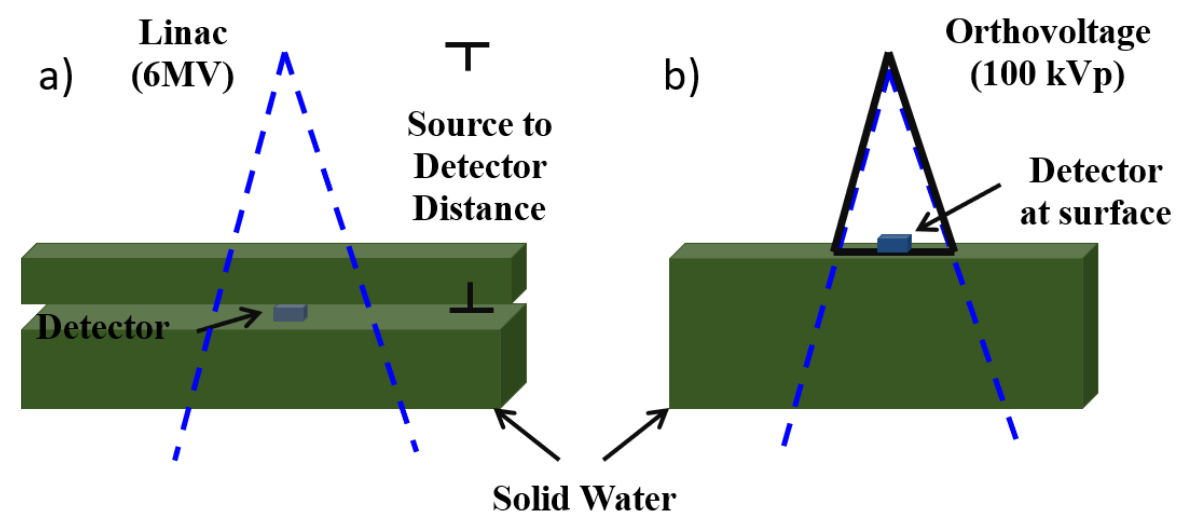
Figure 1. A schematic representation of the setup used to irradiate the OTFT detector with ( a ) a 6 MV photon beam and ( b ) a 100 kVp photon beam. Measurements were performed in Solid Water to mimic a clinical setup and allow us to relate the response of the detector to a known dose in water. An ion chamber was used to calibrate both treatment machines. The dashed blue lines represent the projected shape of the radiation field. The black triangle in ( b ) represents the cone that is physically attached to the orthovoltage x-ray unit and helps collimate the field.